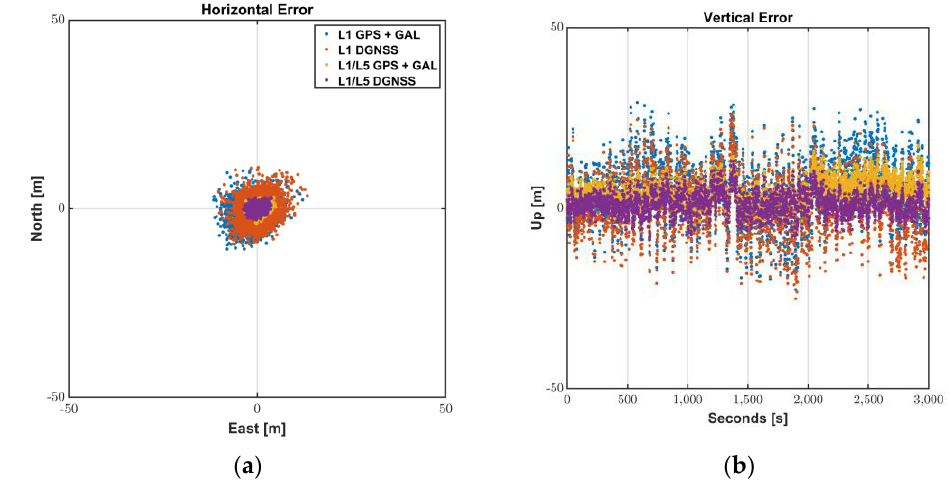
Figure 11. L1/L5 DGNSS positioning results: ( a ) Horizontal Error; ( b ) Vertical Error. Table 5. Statistics of L1/L5 DGNSS positioning results.